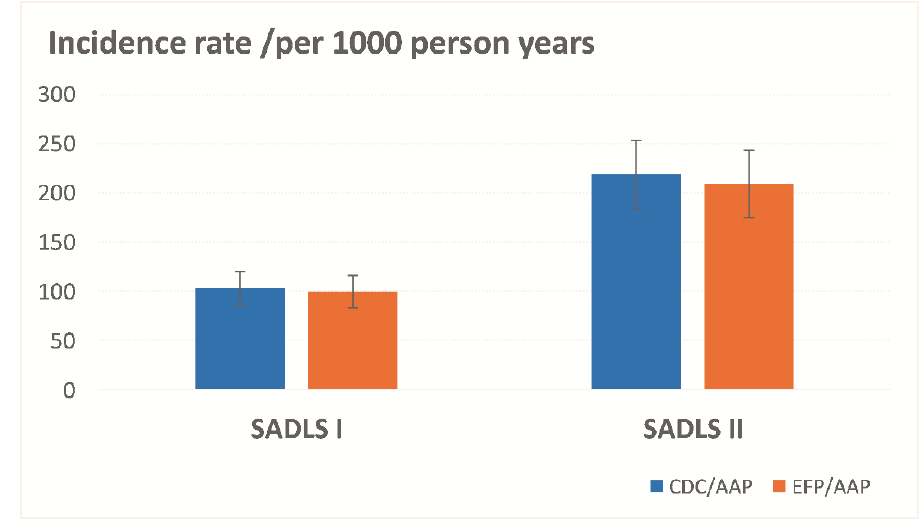
Figure 1. Incidence rate of chronic periodontitis among Australian adults in SADLS I and II under the AAP/CDC and EFP/CDC case definitions.